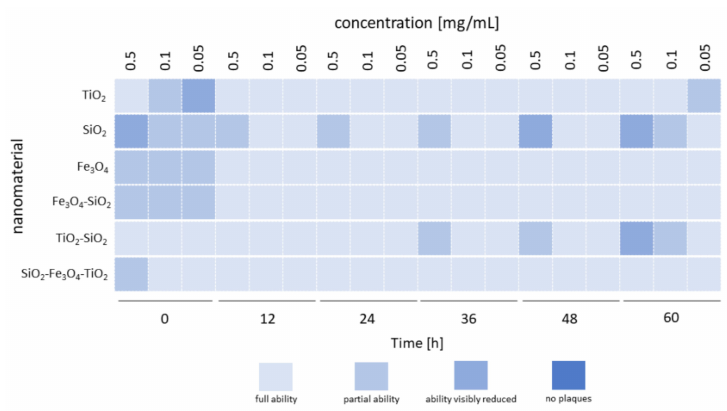
Figure 2. Phage plaque-forming ability after coincubation with selected